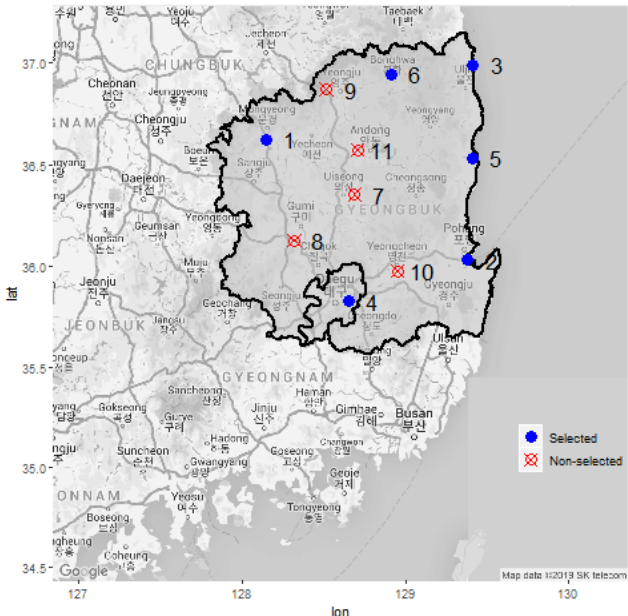
Figure 7. Results of the optimal rain gauge network selection.